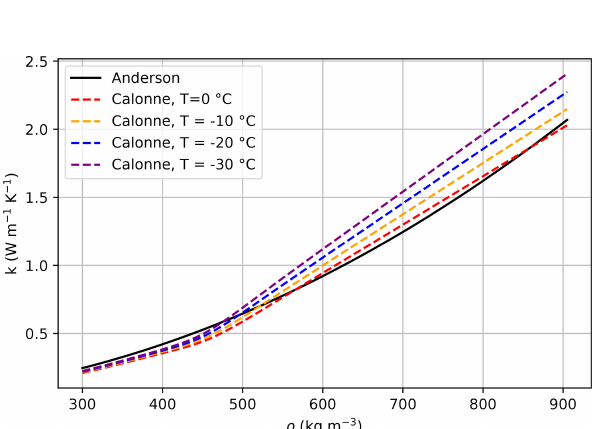
Figure 3. Comparison of the thermal conductivity parametrization by Anderson (1976) and Calonne et al. (2019) with density at dif- ferent